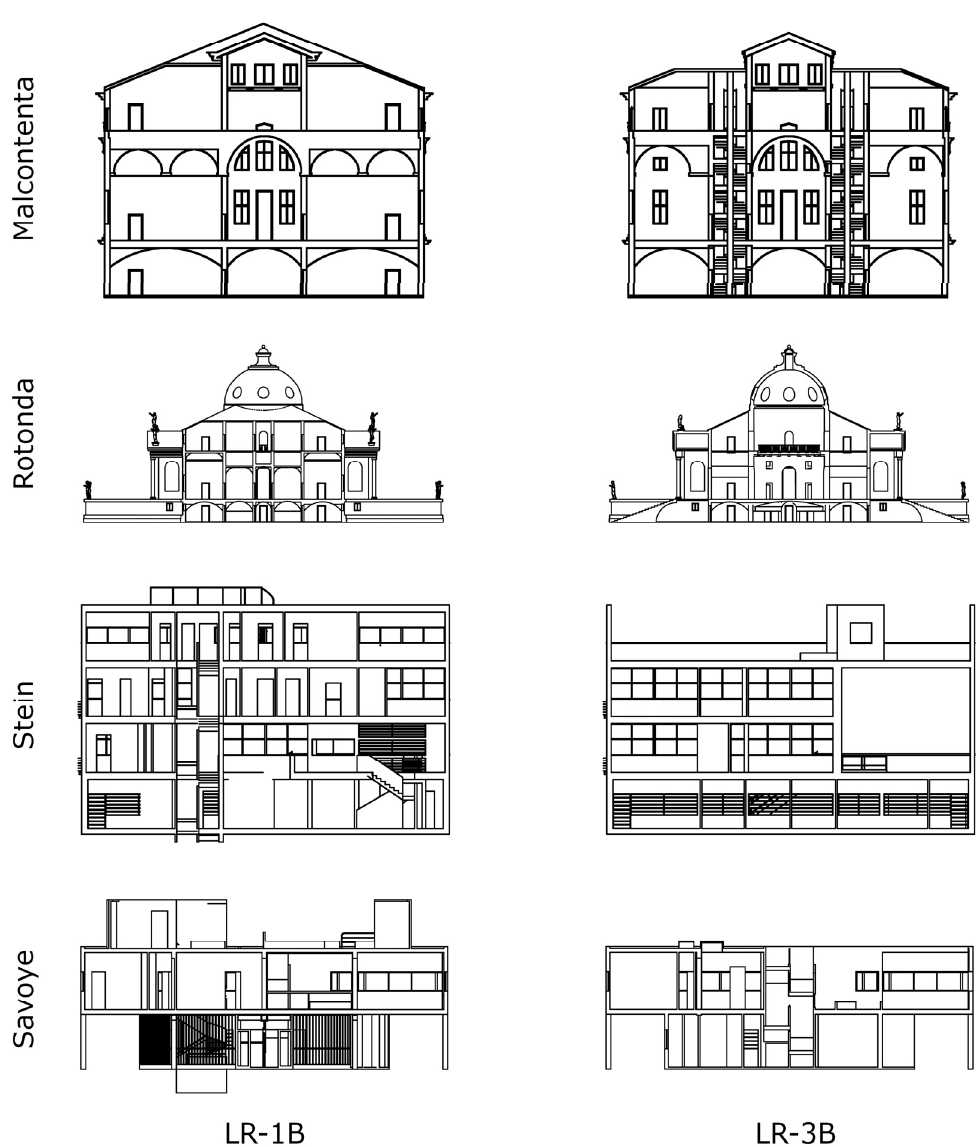
Figure 8. Example sections LR-1B and LR-3B through each villa; note that villas are not shown to the same scale and line thicknesses are increased compared to the analysed images.